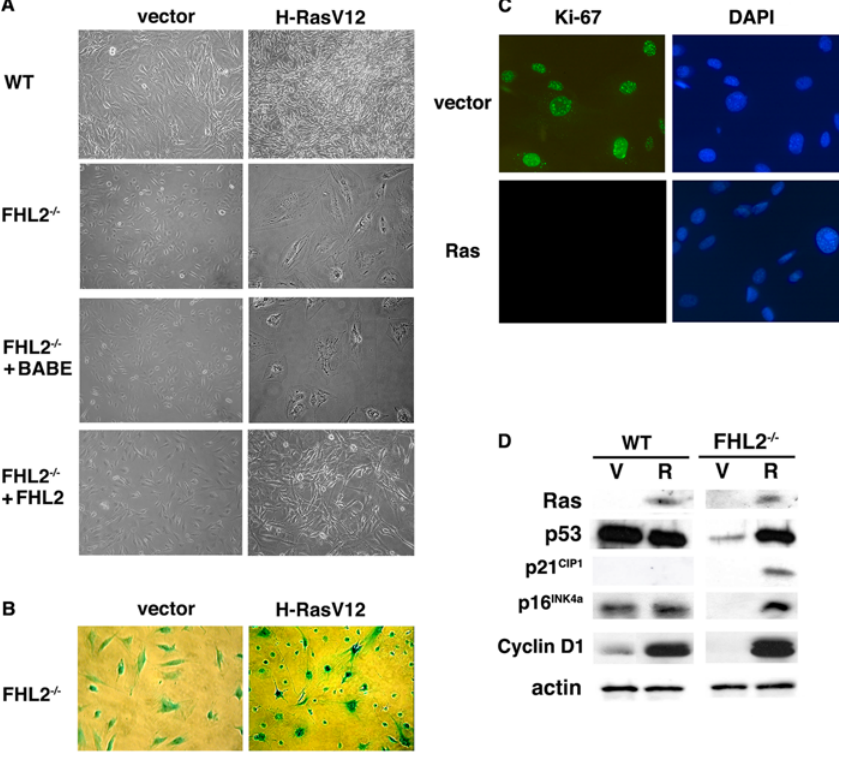
Figure 2. H-RasV12 induces cell cycle arrest in immortalized FHL2 2 / 2 MEFs. (A) Immortalized wt, FHL2 2 / 2 and FHL2 2 / 2 - restored MEFs were infected with pBabe-RasV12 or control pBabe retrovirus and selected for drug resistance. (B) All FHL2 2 / 2 cells were positive in b -galactosidase assay due to the insertion of Lac Z cDNA at the FHL2 locus. (C) Ki-67 immunofluorescence analysis in vector- and H-RasV12-transduced FHL2 2 / 2 MEFs. Nuclei were counterstained with DAPI. (D) Expression of Ras, p53, p21 CIP1 , p16 INK4a and cyclin D1 in H-RasV12- (R) or vector- (V) transduced wt and FHL2 2 / 2 cell lines. Equal amounts of protein extracts were analyzed by immunoblotting.